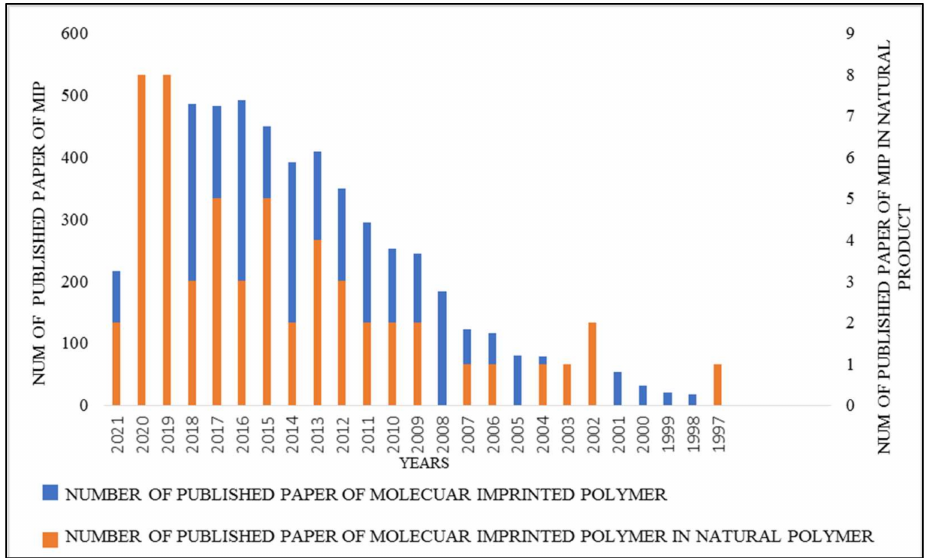
Figure 1. Number of published papers of MIPs and MIPs in natural product found in